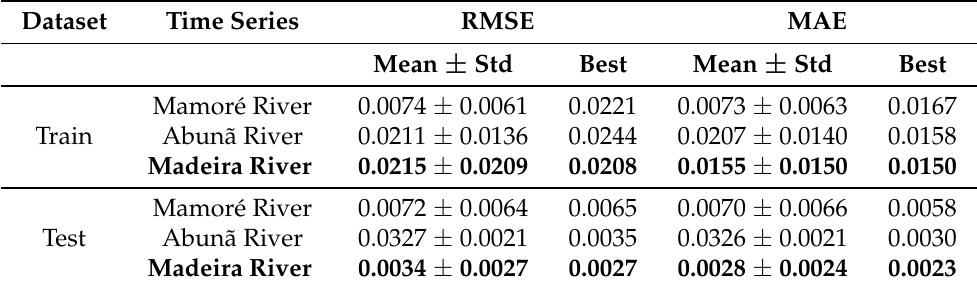
Table 1. Average, standard deviation and best results of 30 realizations on train and test datasets, for four days forecast to Mamoré and Abunã rivers, and five days forecast to Mareda river.